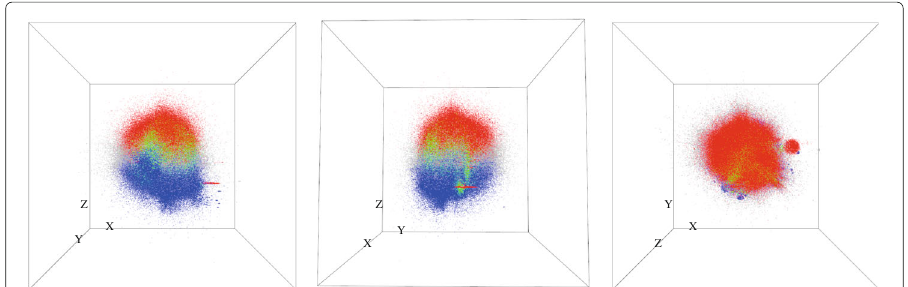
Fig. 6 The IN component (red), GSCC (green), and OUT component (blue) of the TSR transaction network whose layout has been optimized in three-dimensional space. Nodes are aligned in the z direction according to their values of the Helmholtz-Hodge potential; basically, transaction flows are from top to bottom. On the other hand, the x and y coordinates of nodes were determined by the energy minimum principle with a spring-electric